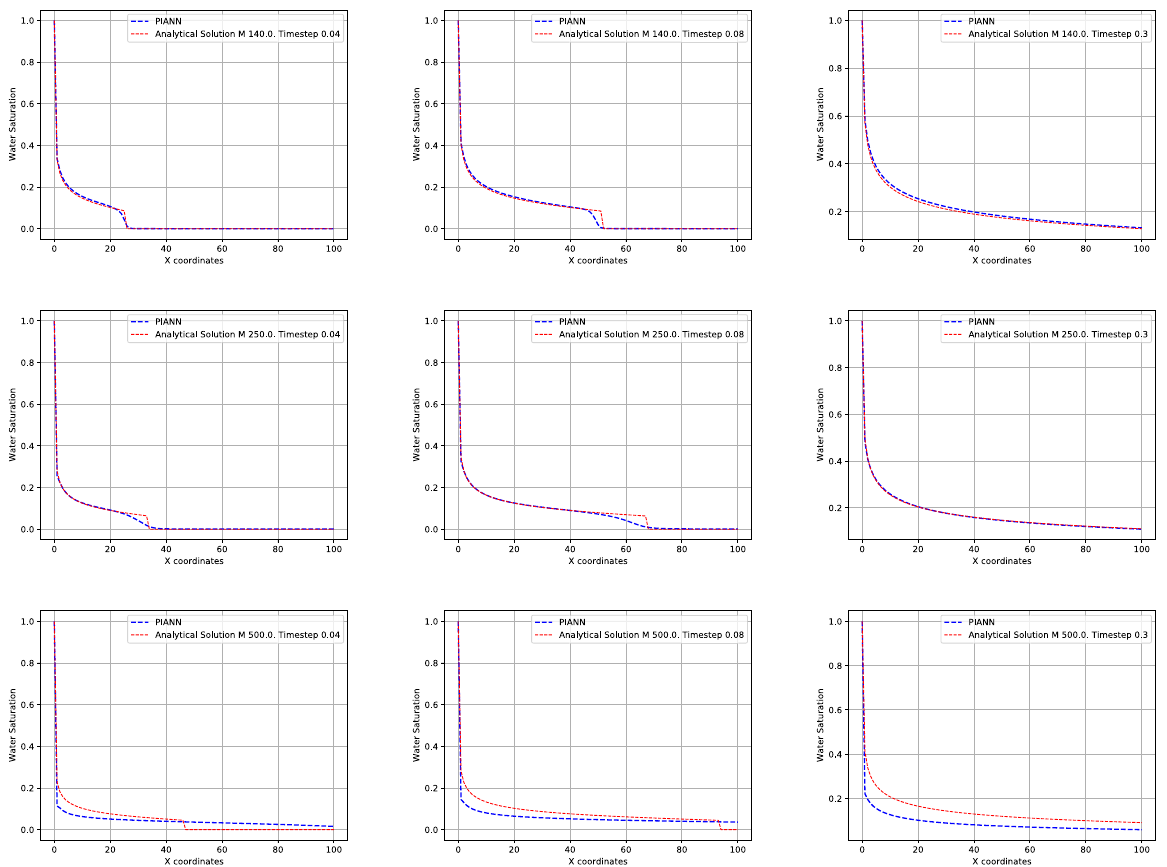
Figure 6. Top and bottom rows correspond to M = 140 and M = 250 and M = 500 comparison of the predicted by the neural network and the exact solutions of the PDE, respectively. The columns from left to right, correspond to different time steps t = 0.04 , t = 0.08 and t = 0.30 .